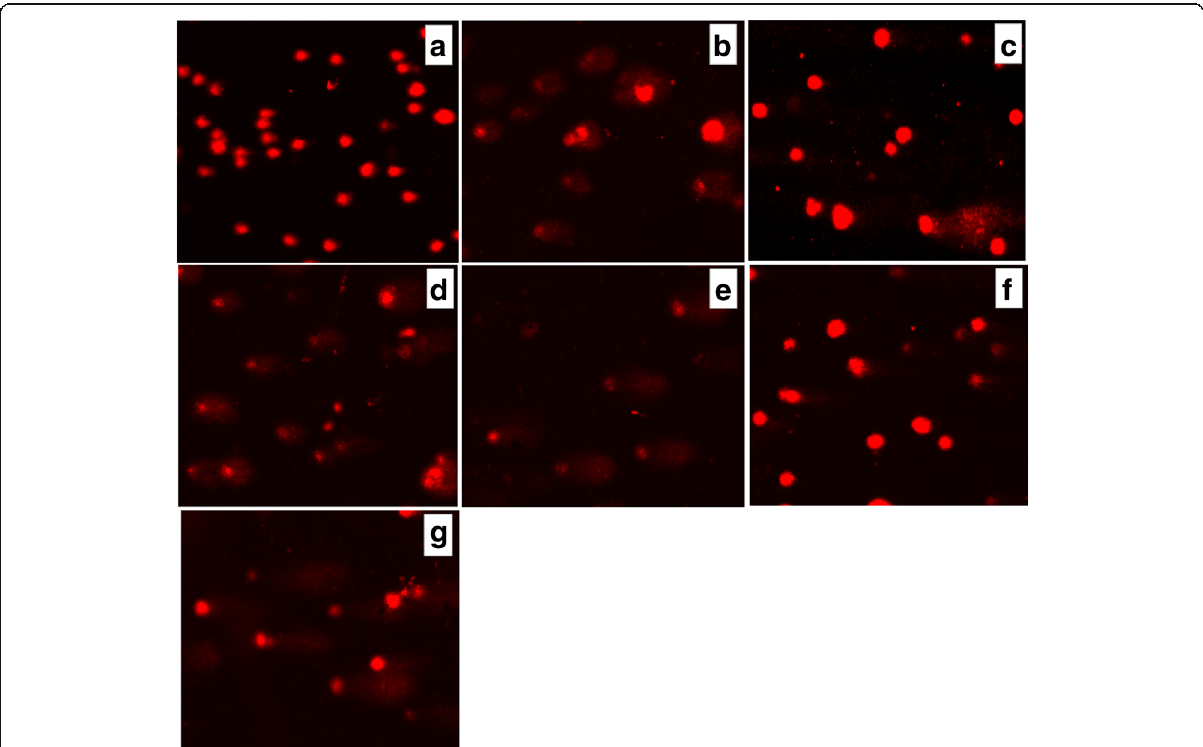
Fig. 12 Presence of DNA in comet tail of rat glioma С 6 cells after treatment for 6 h with ( a ) control (untreated cells), Les-3288 ( b ), Les-3288 + PNC ( c ), Les-3833 ( d ) Les-3833 + PNC ( e ), PNC ( f ), and doxorubicin ( g ), used at a 0.5 μ g/mL concentration